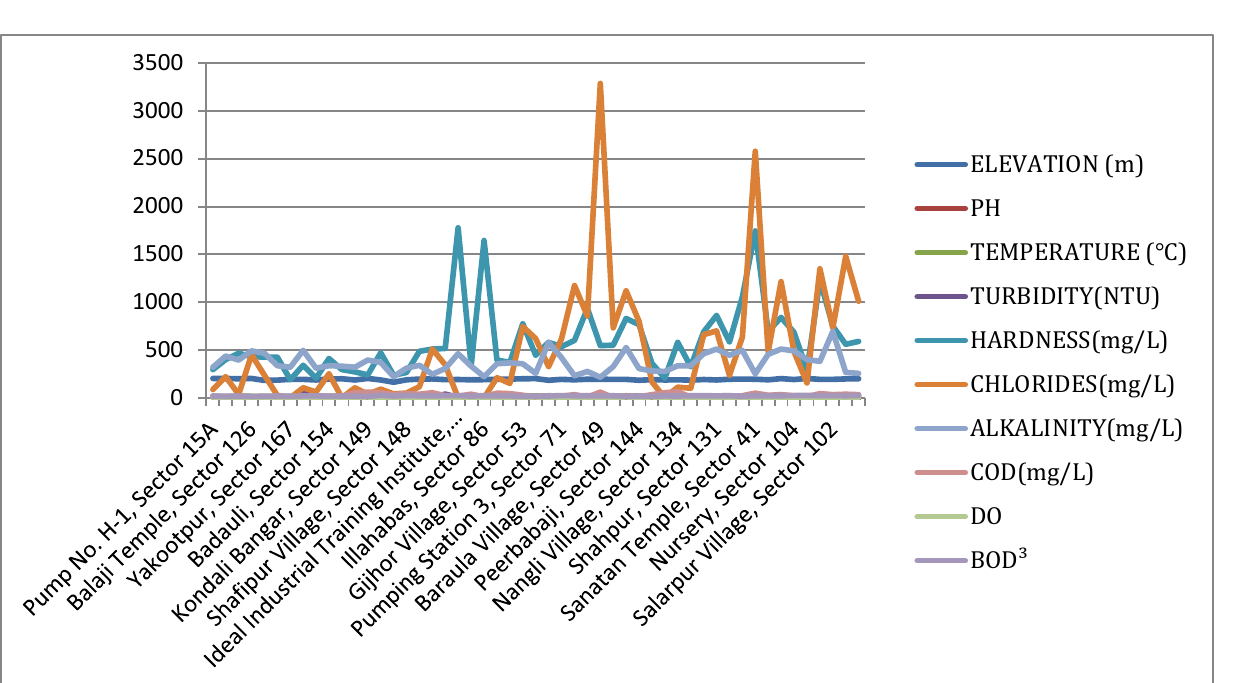
Figure 1. Distribution of Factors from different locations of Noida and Delhi.